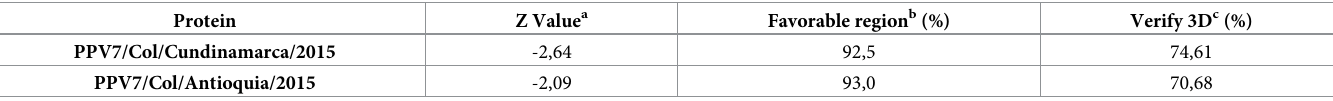
Table 2. Computational validations of Colombian PPV7-VP2 capsid protein models. Protein Z Value a Favorable region b